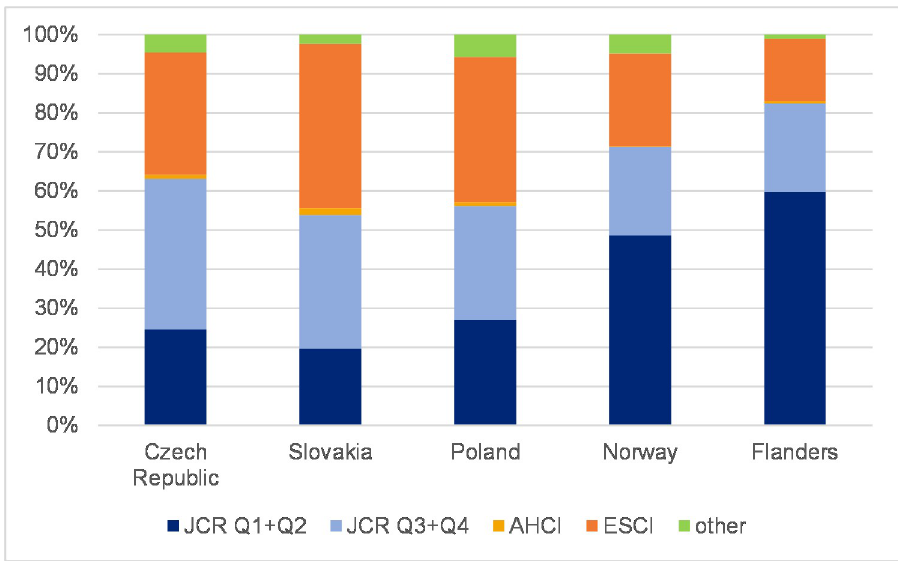
Fig 5. Proportion of articles in WoS by citation indexes–social